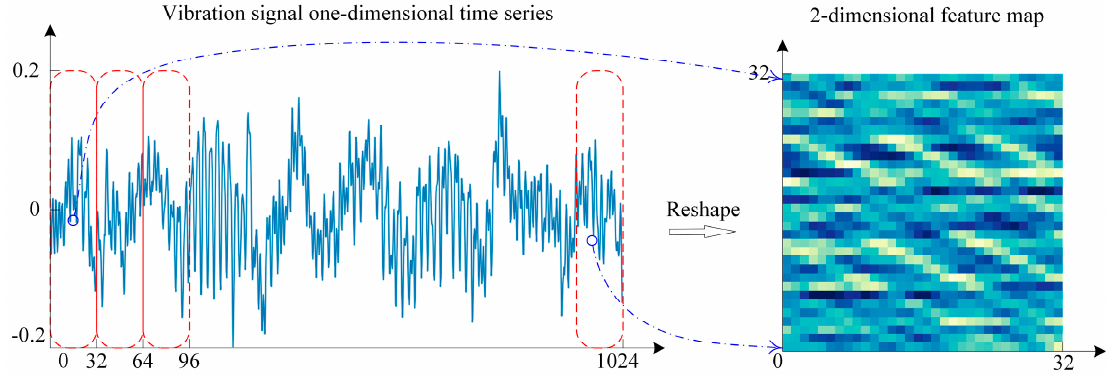
Figure 4. The process of data reconstruction. Table 1. GL-mRMR-SVM parameters.